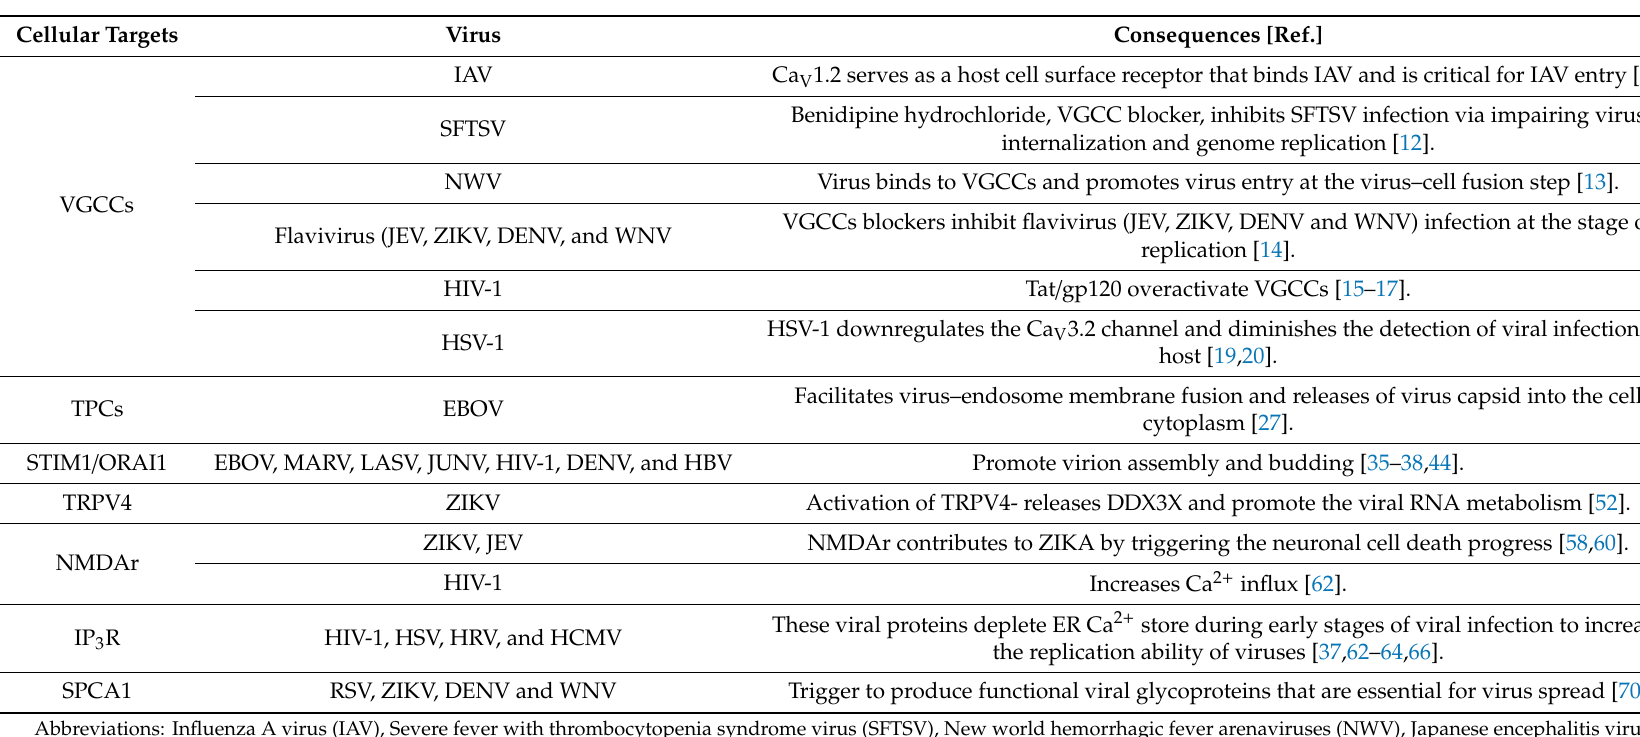
Table 1. Calcium channels / pumps utilized by a